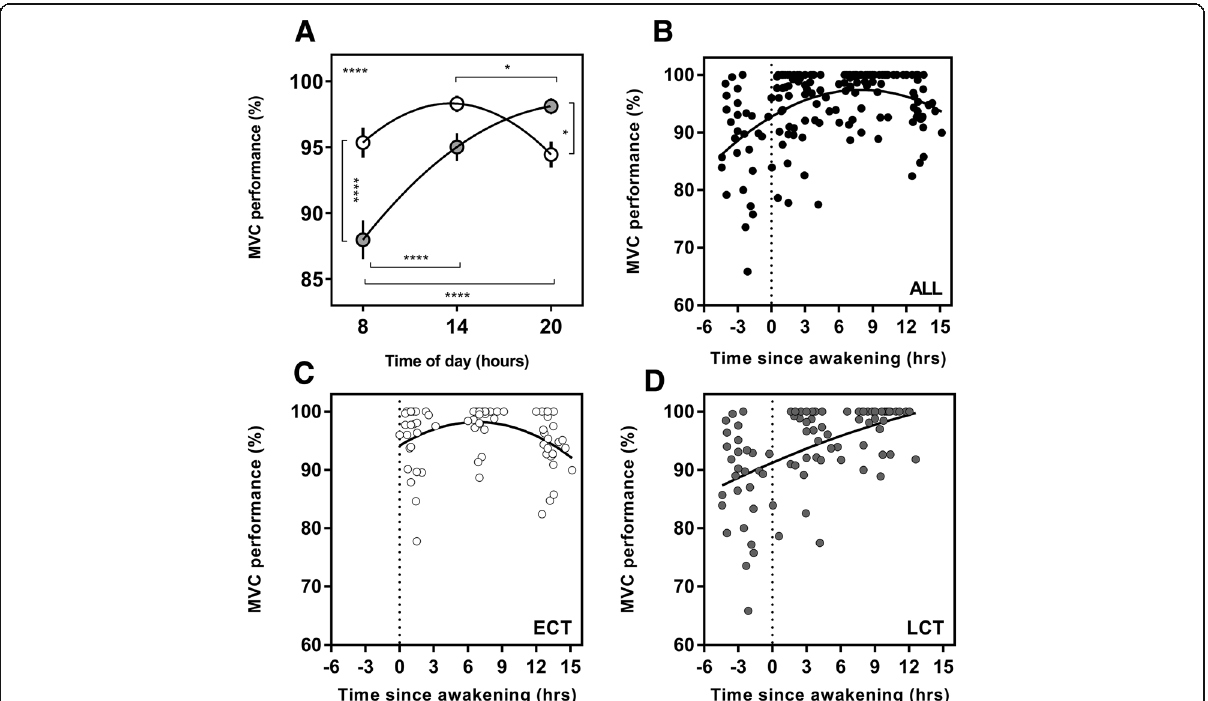
Fig. 4 Diurnal variation in maximum voluntary contraction (MVC) and MVC as a function of time since awakening. Clock time variation ( a ) in PVT performance between ECTs (white circles) and LCTs (grey circles). MVC as a function of time since awakening for all subjects ( n = 56; b ), ECTs ( n = 25; c ), LCTs ( n = 31; d ). Data are expressed as the percentage of individual personal best performance. Entrained wake-up time, i.e. biological time 0, is shown with the dotted line. Curves are second-order polynomial non-linear regressions. The significance is shown as * = p < 0.05, ** = p < 0.01, *** = p < 0.001, **** p < 0.0001. The result shown in the upper left of ( a ) plots represents the interaction between the time of day and chronotype derived from the overall two-way ANOVA. Post hoc test results are shown with lines and asterisk between the time of day and chronotype